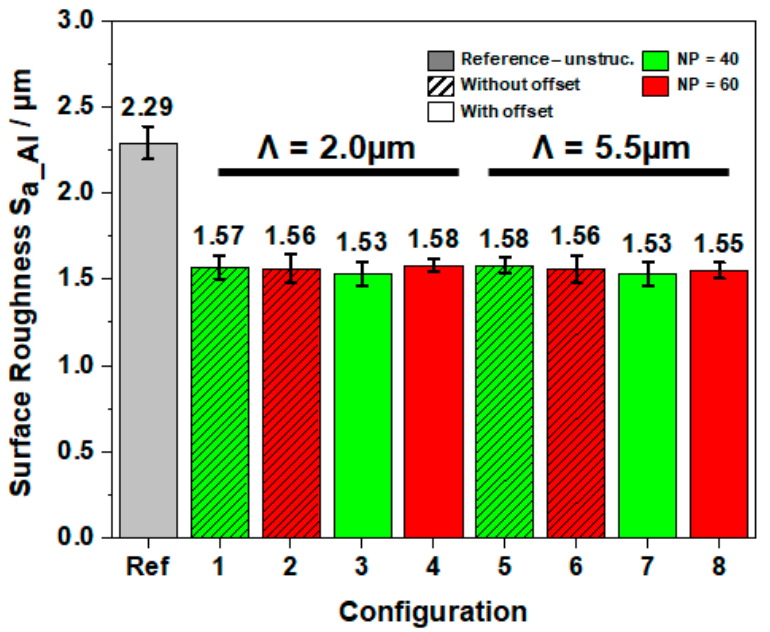
Figure 7. Measured micro-surface roughness after turning experiments of AL 6061 T6 for the different tool modifications .